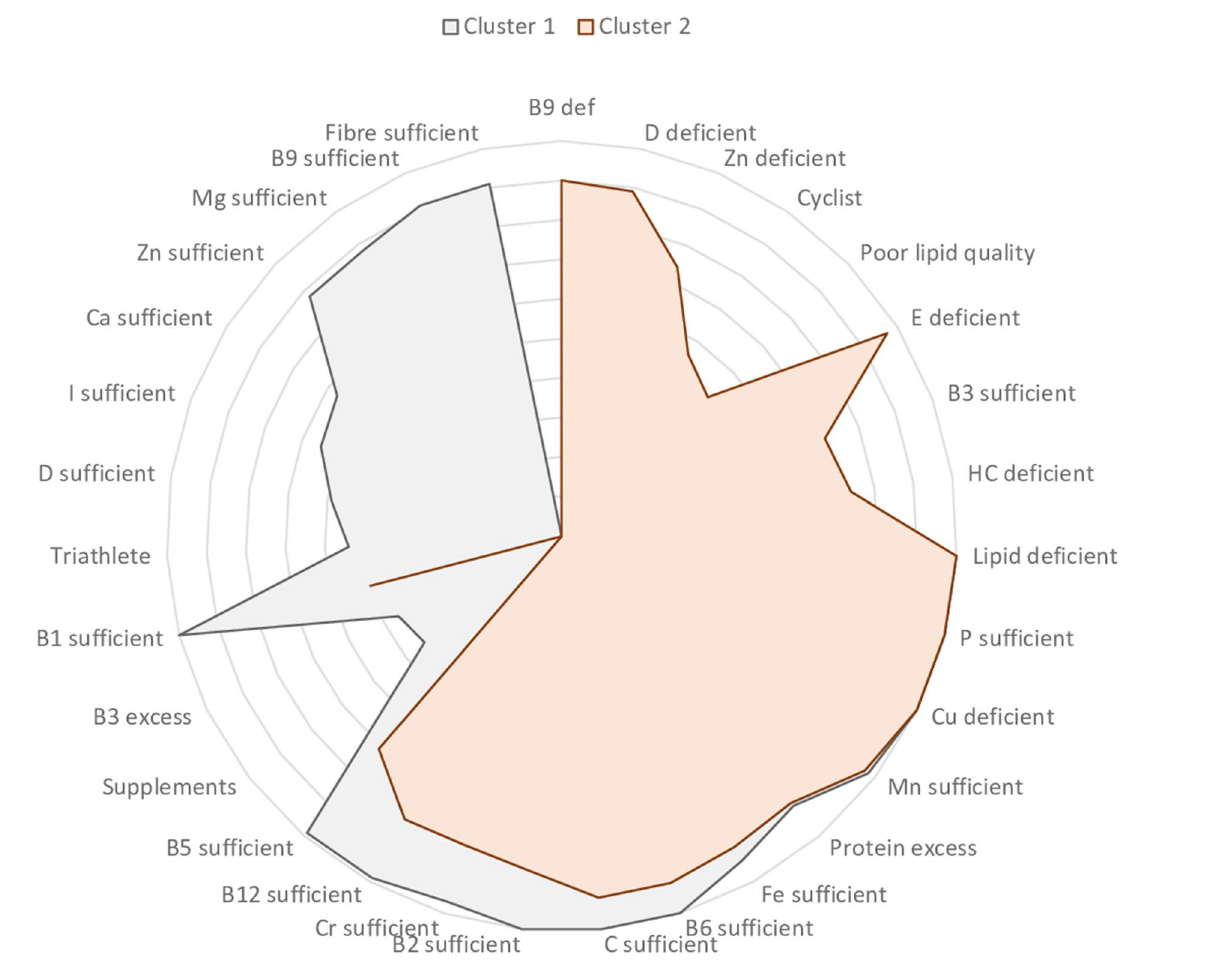
Figure 1. Graph of mean centres for all micro- and macronutrients and cluster formation. Footnote: Cluster 1 (54.4%) – somewhat deficient: carbohydrate deficient: lipid deficient, excess vitamin B3, vitamin E deficient, excess protein, takes supplements, triathlete; Cluster 2 (45.6%) – highly deficient: carbohydrate deficient, lipid deficient, vitamin B9 deficient, vitamin D deficient, vitamin E deficient, calcium deficient, zinc deficient, excess protein, vitamin B1 deficient, iodine deficient, magnesium deficient, fibre deficient, poor lipid quality,